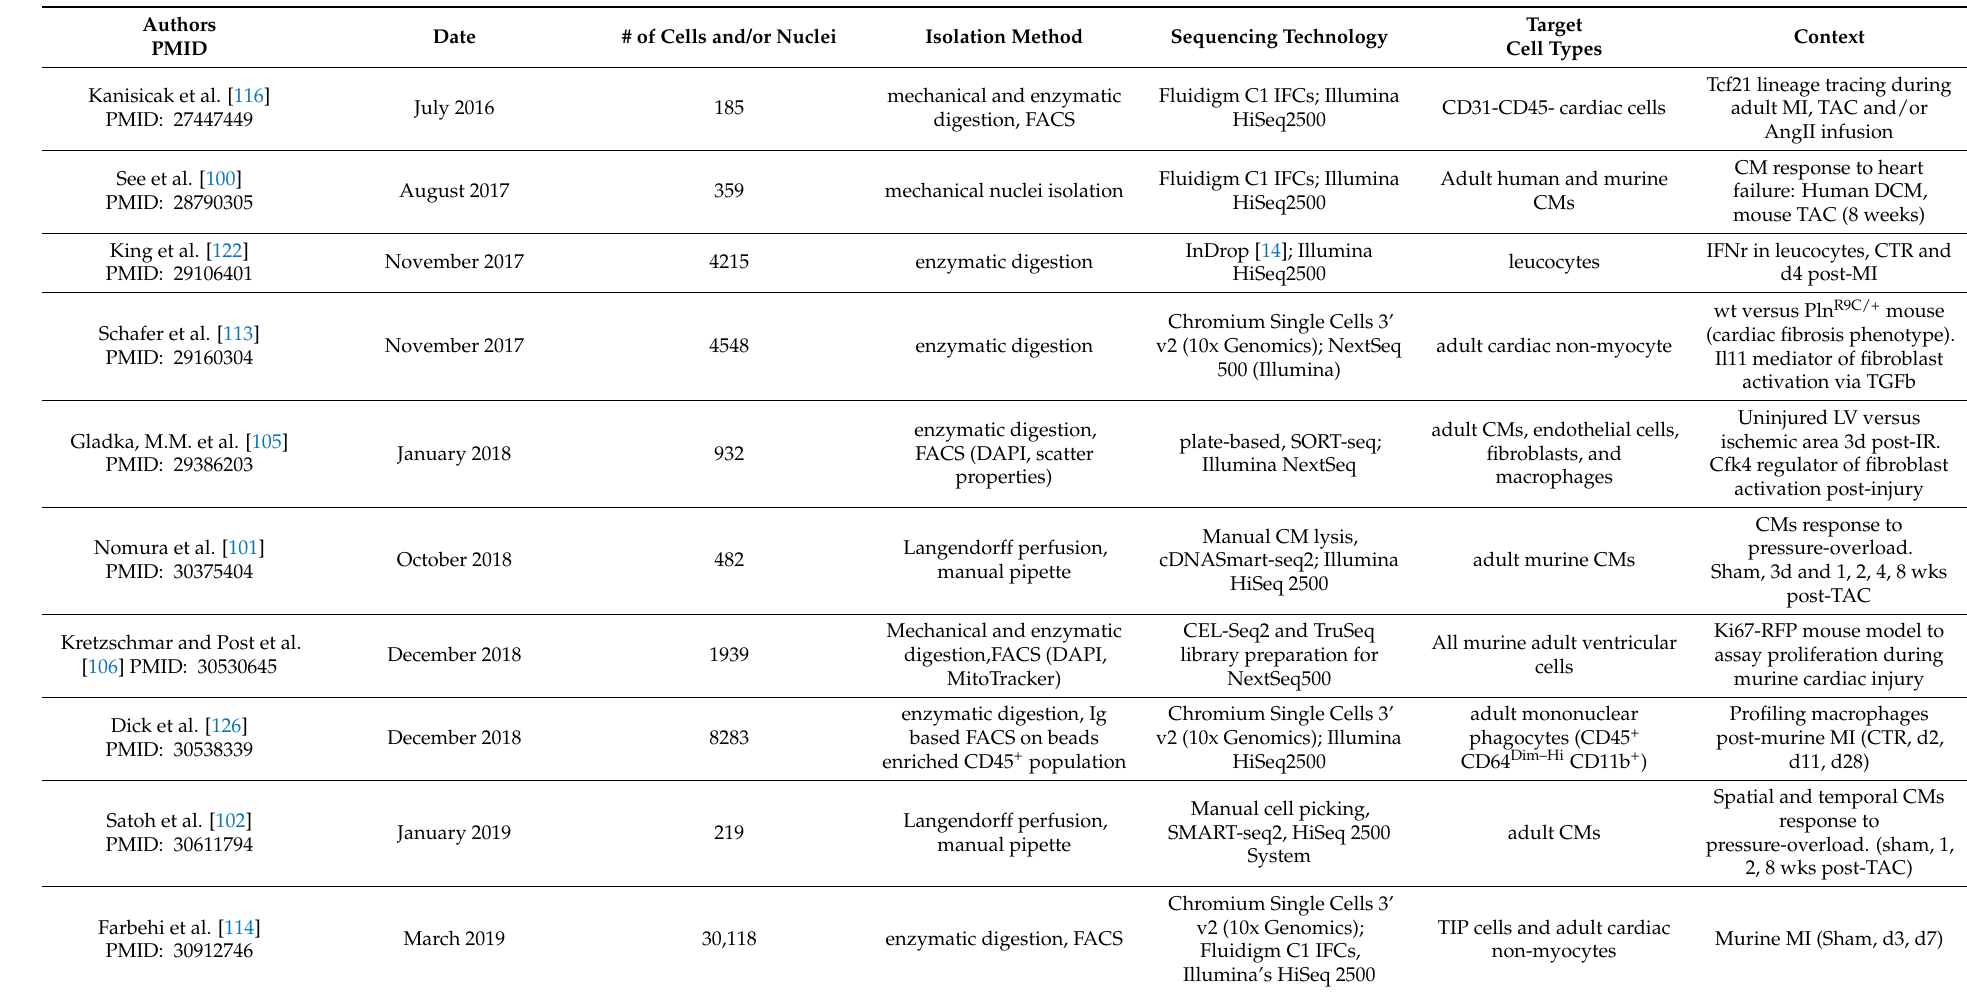
Table 5. Cardiac Injury in Non-Regenerative